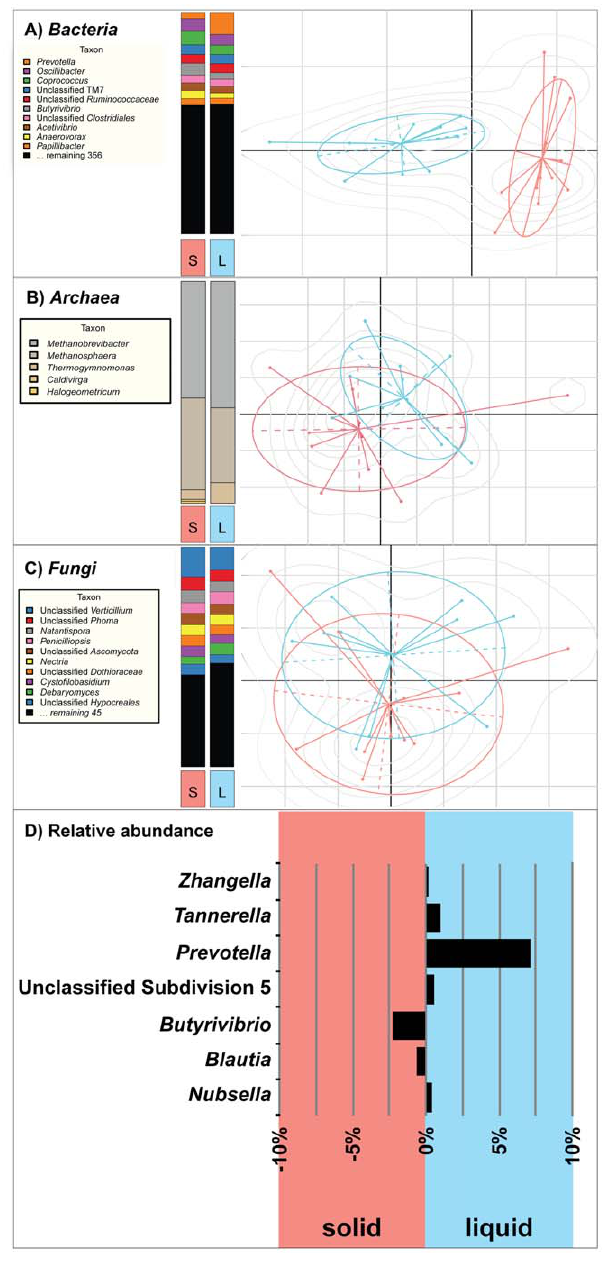
Figure 3. Comparison of microbial diversity in bovine rumen solid (S) and liquid (L) fractions in 12 cows. Bar-charts (left panels) and PCA scatter plots (right panels) display the OTU-based taxonomic profiles and similarity among profiles, respectively for Bacteria (A), Archaea (B), and Fungi (C). The relative abundance of seven bacteria with significant differences in liquid and solid fractions of the rumen was plotted (D).